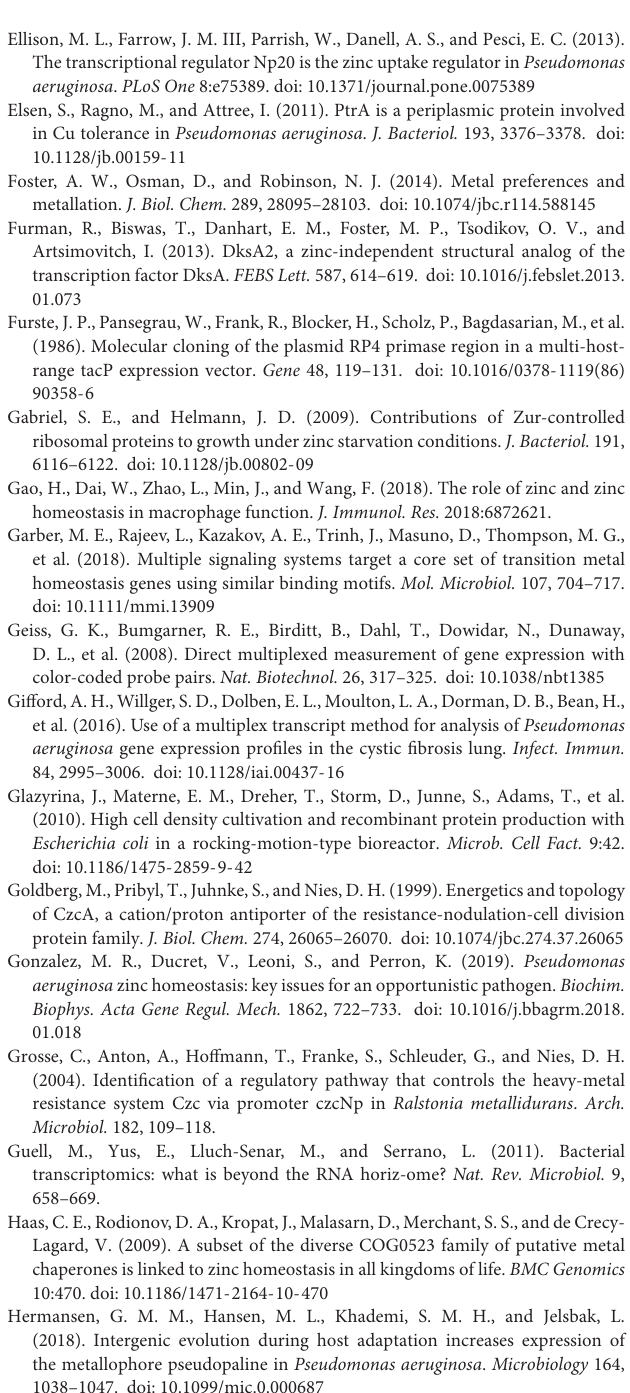
Supplementary Table 1 | Proteomic results for systems involved in Zn homeostasis before and after addition of 2 mM ZnCl 2 , as indicated. Mean values of three independent experiments and standard deviations are indicated. Undetected proteins are highlighted in gray. Only one value of the triplicate was obtained for FolE. Supplementary Table 2 | NanoString codeset details.